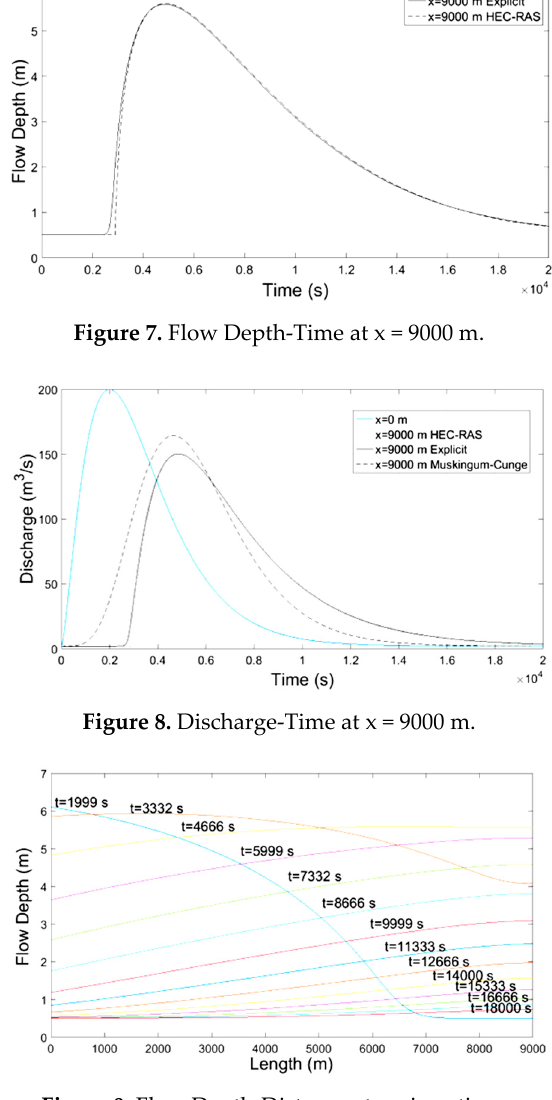
Figure 9. Flow Depth-Distance at various